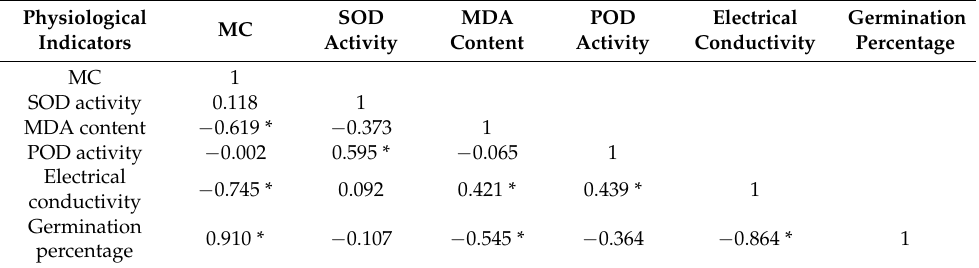
Table 2. Correlation coefficients ( r ) for physiological changes in G. biloba seed during desiccation. Physiological SOD MDA MC Activity Indicators